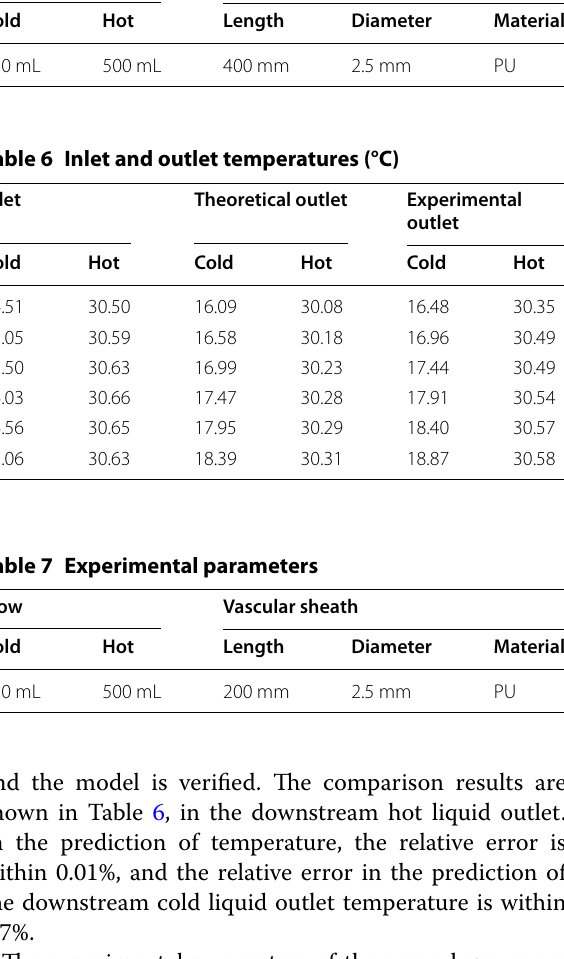
Table 5 Experimental parameters Flow